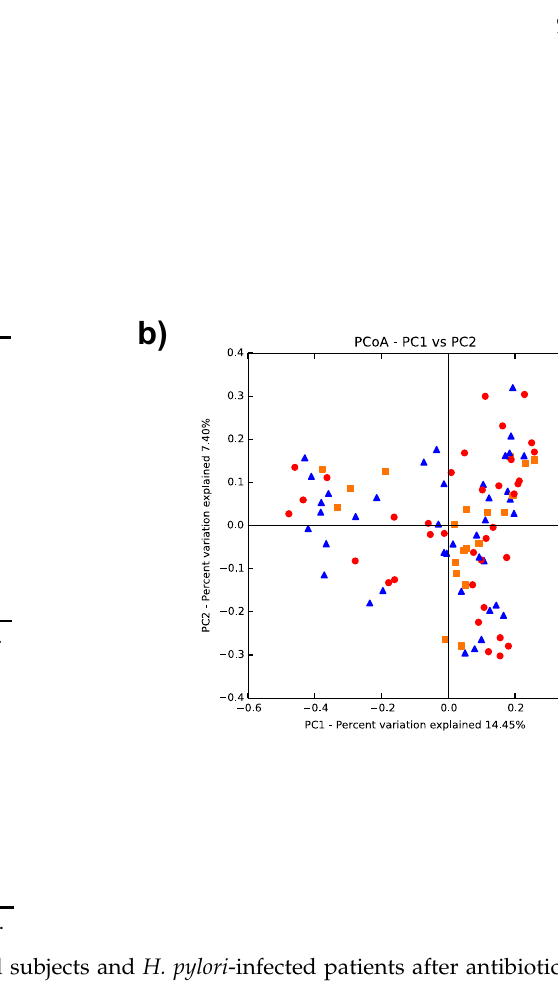
Figure 2. Estimation of diversity in control subjects and H. pylori -infected patients after antibiotic treatment. ( a ) Richness and diversity indices among different groups were compared. Wilcoxon test was used to compare the group of H. pylori -infected patients before and after antibiotic treatment. Equal letters indicate statistical differences between those groups. a : differences between H. pylori -infected patients before and after antibiotic treatment, p < 0.05. b : differences between H. pylori -infected patients compared to the control group, p < 0.05. c : differences between patients’ post-antibiotic treatment versus control group, p < 0.05. All values are means ± standard error of the mean. ( b ) Clustering of gut microbiota populations according to the study groups by principal coordinate analysis (PCoA) using the Bray–Curtis dissimilarity. No statistical differences were observed between groups. Orange squares belong to the control subject group; blue triangles to patients before treatment; and red dots to patients after treatment.